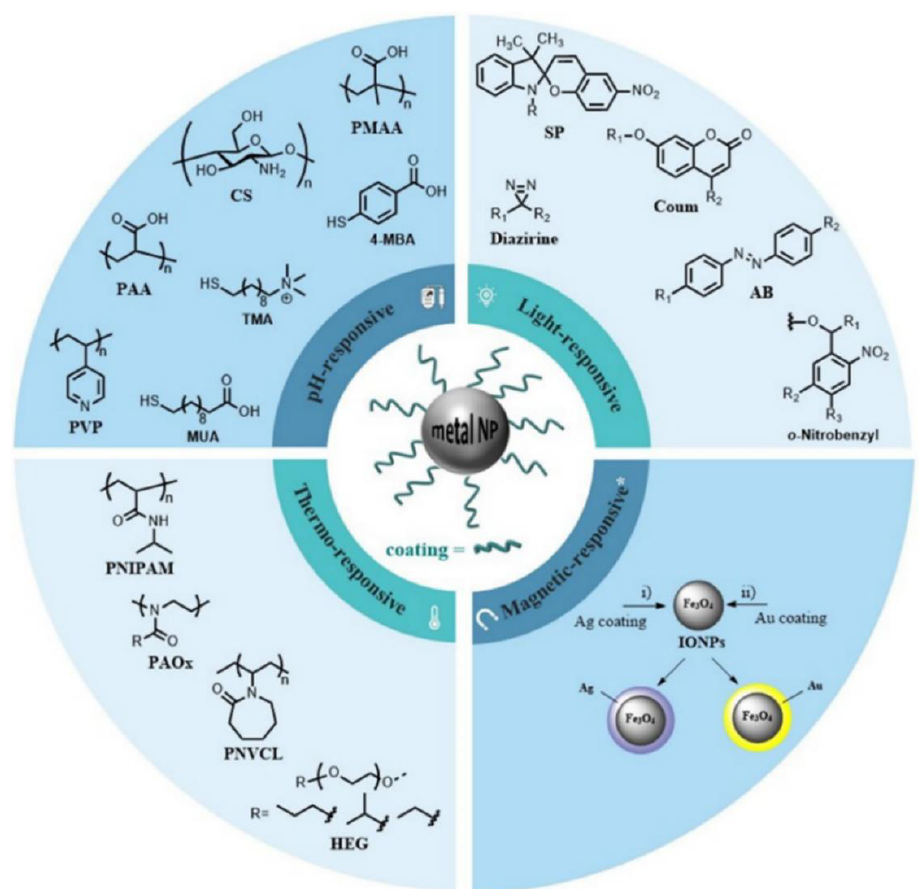
Figure 1. Examples of commonly used moieties for coating metal NPs to produce stimuli-sensitive nanosystems. Reproduced from [12], MDPI, 2021.